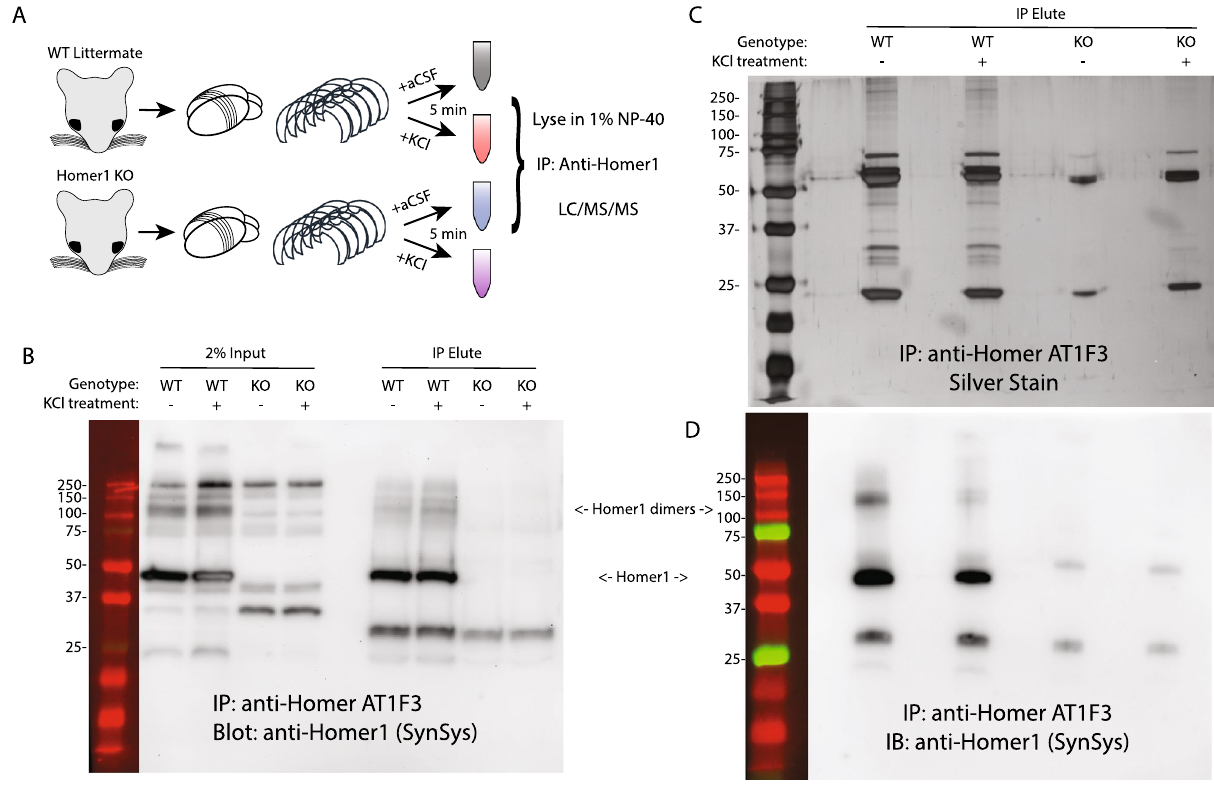
Figure 1. Sample preparation for mass spectrometry. ( A ) Experimental design. ( B ) Western blot of representative immunoprecipitation showing Homer1 bands at the expected molecular weight. ( C ) Silver stain showing protein co-IP’d in WT and KO mice. ( D ) Western blot on the same blot as the silver stain showing Homer1 protein at the expected molecular weight.